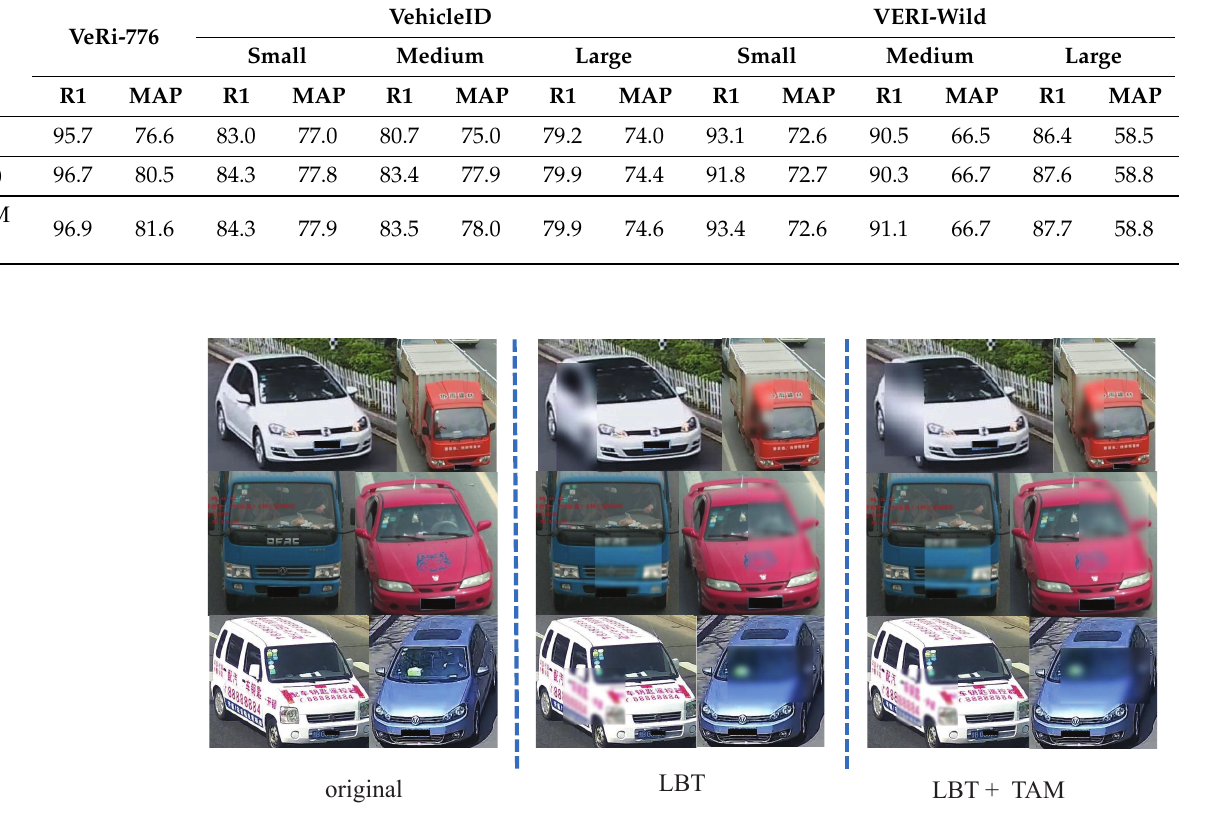
Figure 7. Overview of Augmentation Results. Column 1: original samples. Column 2: augmented samples created by LBT. Column 3: augmented samples created by LBT +